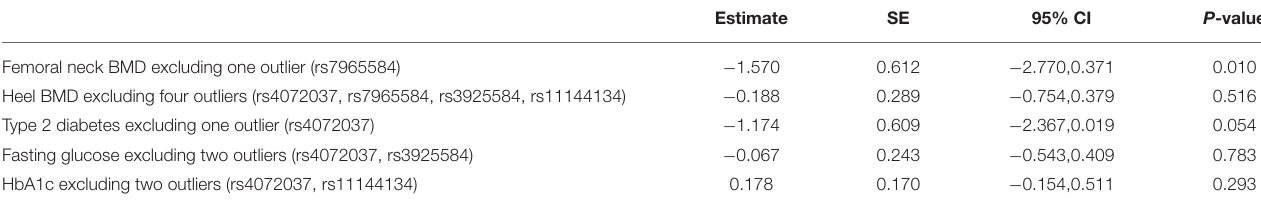
Estimate SE 95% CI P -value